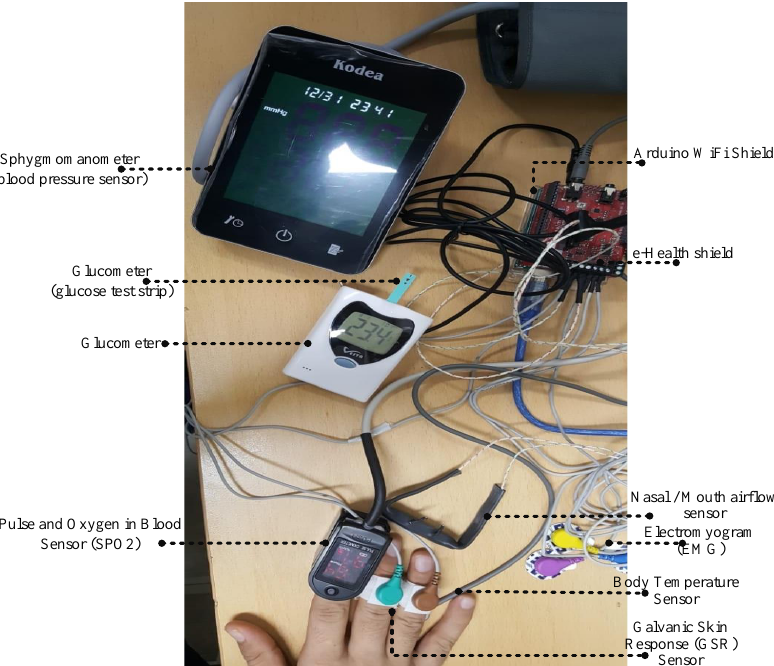
Figure 7. Experimental environment of medical blockchain